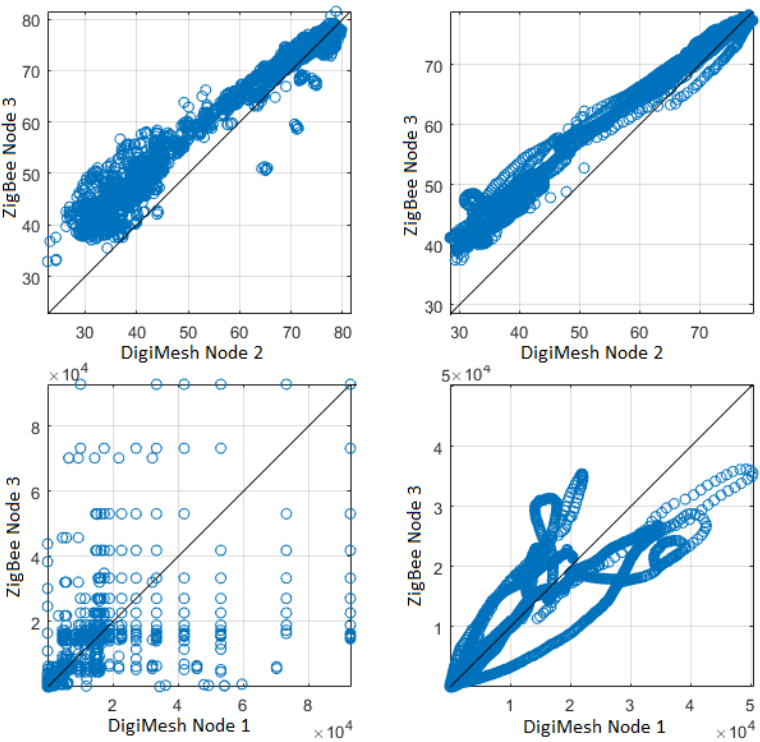
Figure 17. Scatterplots between two Sensor Nodes in the DigiMesh and ZigBee networks: ( top ) air relative humidity, showing the strong similarity and the patent bias in both cases; ( bottom ) luminosity; ( left ) not filtered; and ( right )